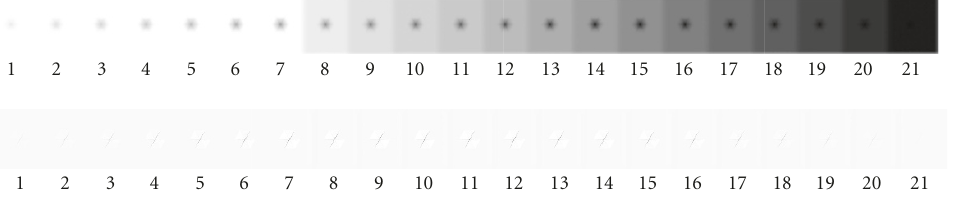
Figure 3: Example results of di ff erent cross-correlation algorithms (top—CCA; bottom—FLA). The test image contains triangles varying in brightness (see Figure 1). The 7th image shows the result for the original image. High coe ffi cients are black, low coe ffi cients are